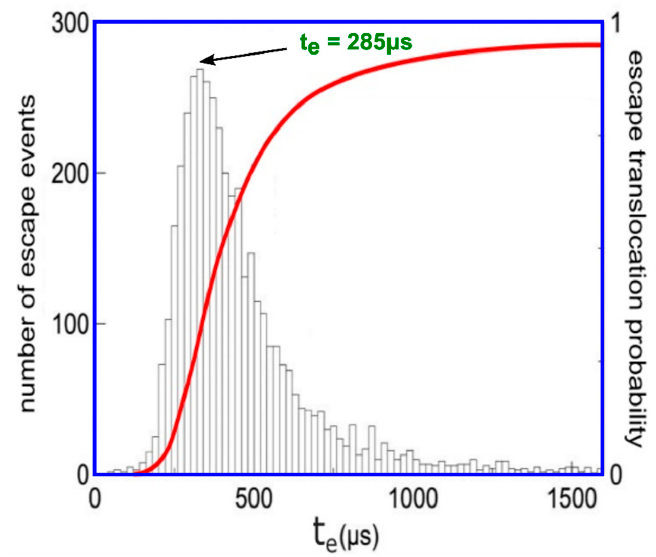
Figure 5. Escape translocation probability as a function of escape time.